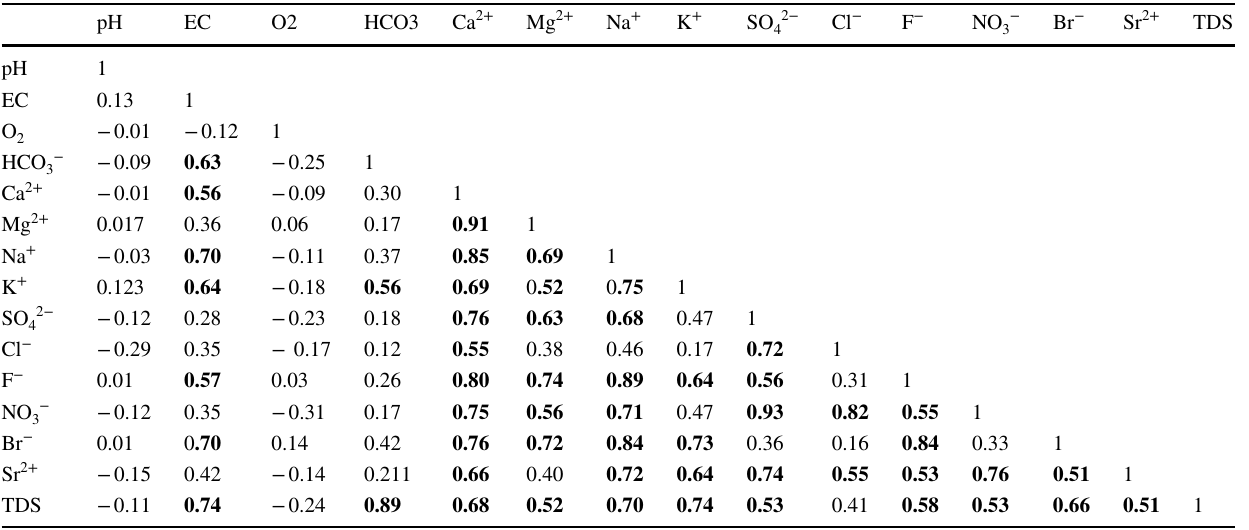
Table 2 The correlation matrix for water quality parameters in the study area